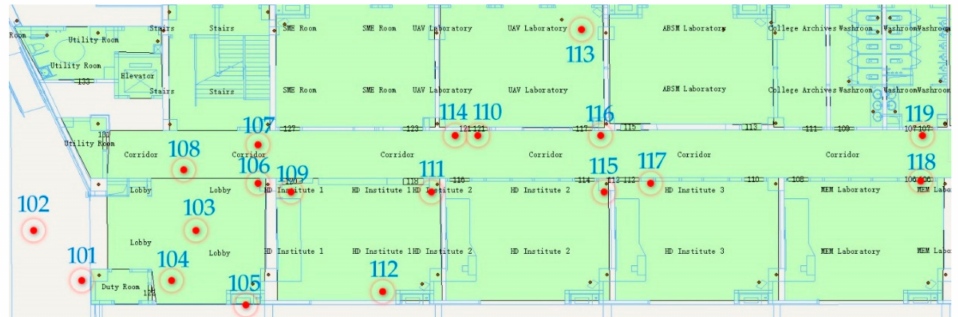
Figure 8. Indoor Map and the approximate position UWB anchors on the first floor of the